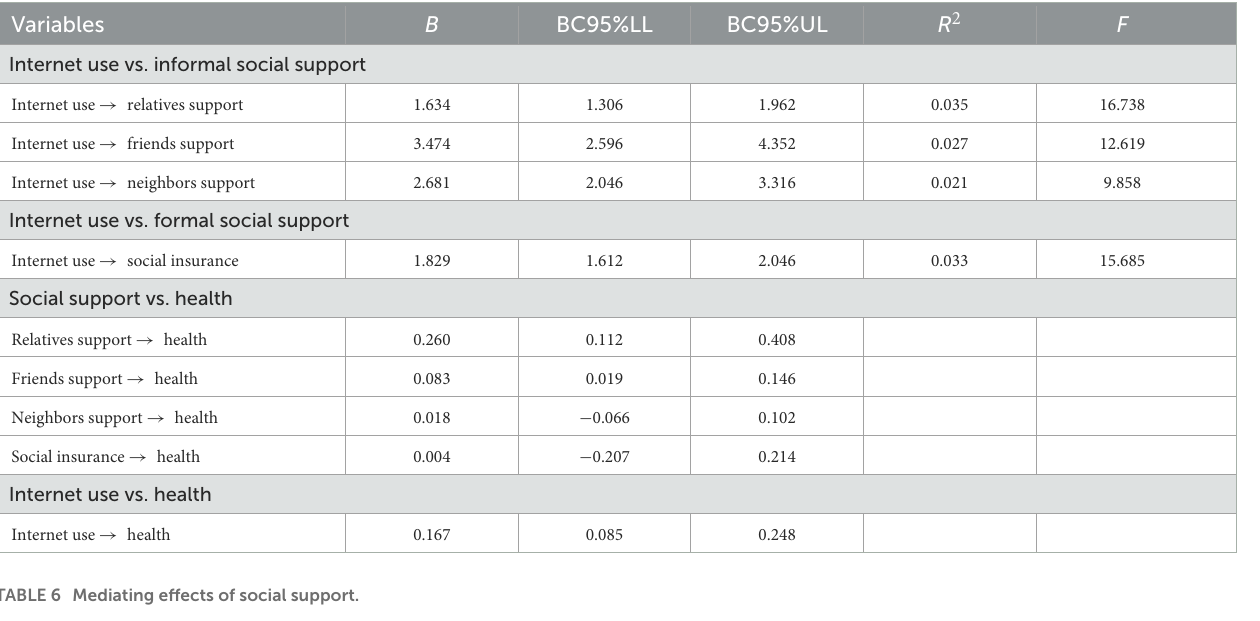
TABLE 5 Path-coefficients of the mediating models.